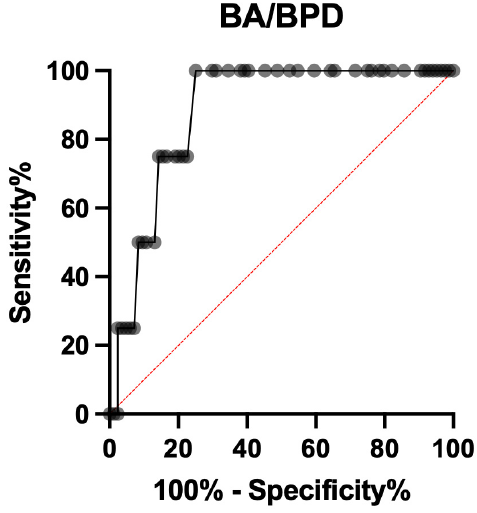
Figure 4. ROC curve of BA/BPD for shoulder dystocia prediction. The difference between BA and BPD had an AUC of 0.857 (95%, CI 0.750 to 0.963; p = 0.016), with a positive likelihood ratio of 4.446 at a threshold of at least 54.8 mm, with a 75.00% sensitivity (9%5 CI 30.06% to 98.72%) and 83.13% specificity (95% CI 73.66% to 89.68%) (Figure 5).